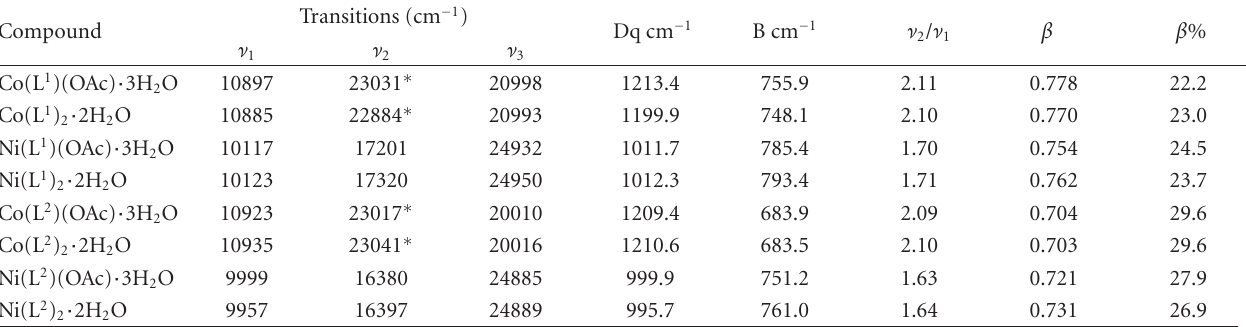
Table 3: Electronic spectral data of metal